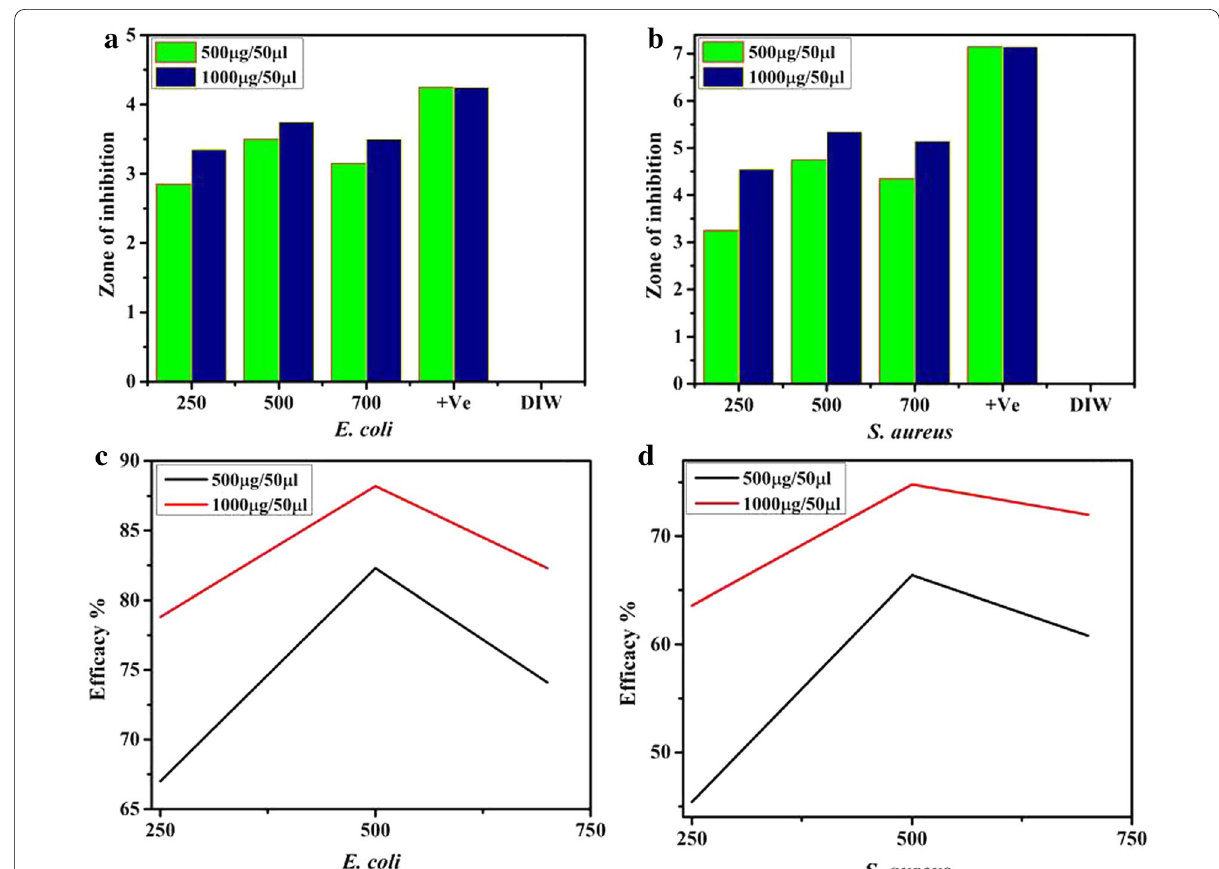
Fig. 11 a In vitro bactericidal action of SnO annealed at different temperatures for E. coli b S. aureus c In vitro bactericidal efficacy %age of fabricated NPs for E. coli (d) and S. aureus , respectively